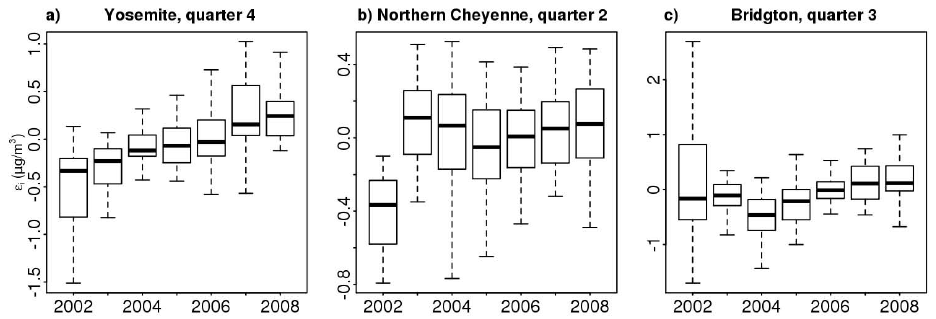
Fig. 7. (a) Residual error values ( ε i ) from quarter 4 at Yosemite National Park show a monotonically increasing trend between 2002 and 2008. (b) In the quarter 2 regression of Northern Cheyenne data, the inter-quartile range of ε i in 2002 does not overlap with other years. (c) There is a substantially larger spread in ε i during quarter 3 at Bridgton, Maine in 2002 than in all other